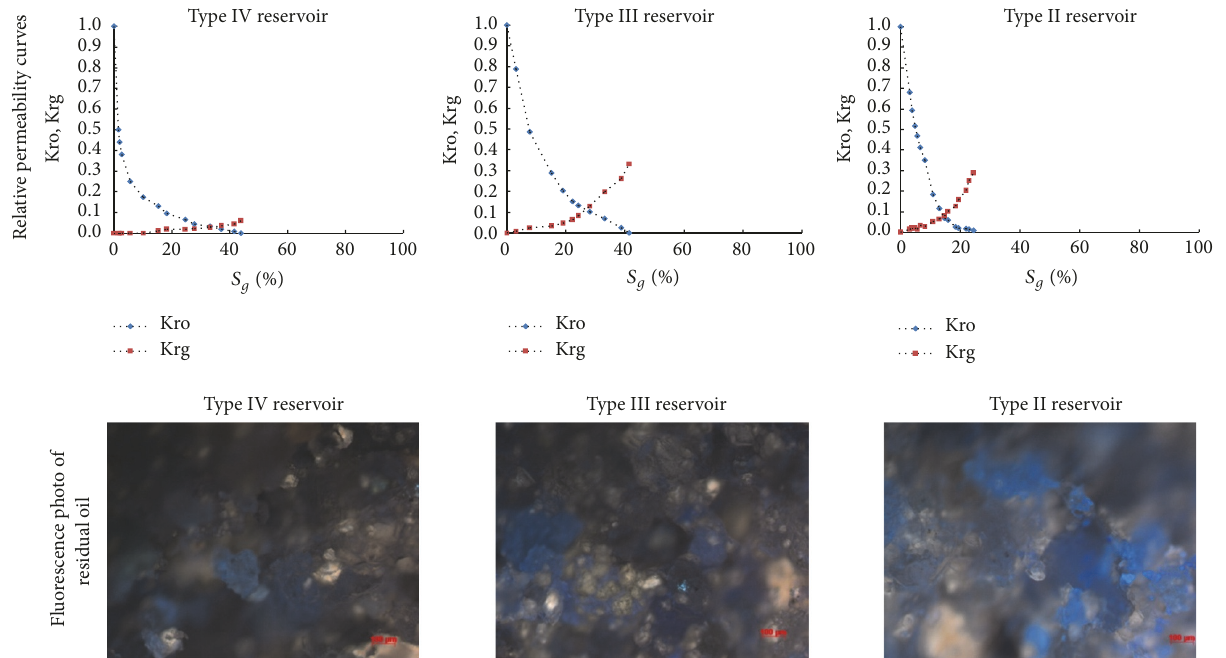
Figure 6: Curves of oil & gas phase-permeability in three types of reservoirs and photos of residual